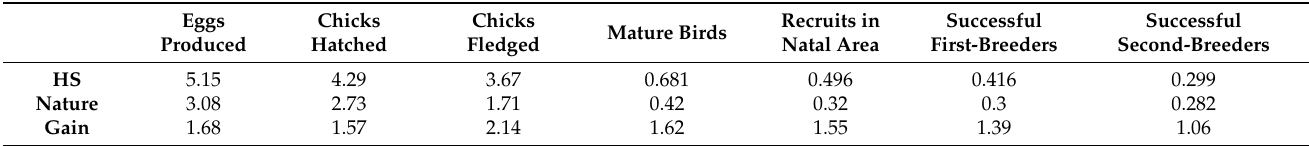
Figure 8. Number of pairs recorded in the Meinypil’gyno area 2013–2022. Different colours show the numbers of pairs consisting of birds marked as wild chicks, those marked as HS chicks, with two-colour hatching showing pairs consisting of partners marked as wild and HS chicks. Wild adults were marked as adults or remained unmarked. Table 5. Evaluation of HS gain at different stages per a pair in the study